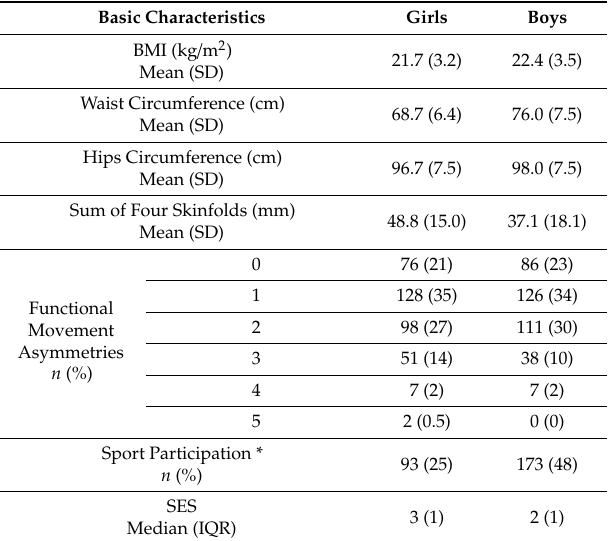
Table 1. Basic characteristics of participants by